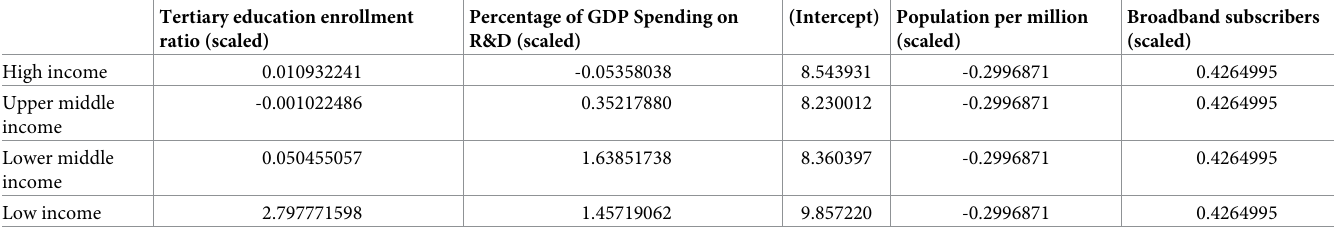
Table 6. Global models V. R&D and education random effects model by income category (DV: download per capita rounded, quasipoission). Tertiary education enrollment ratio